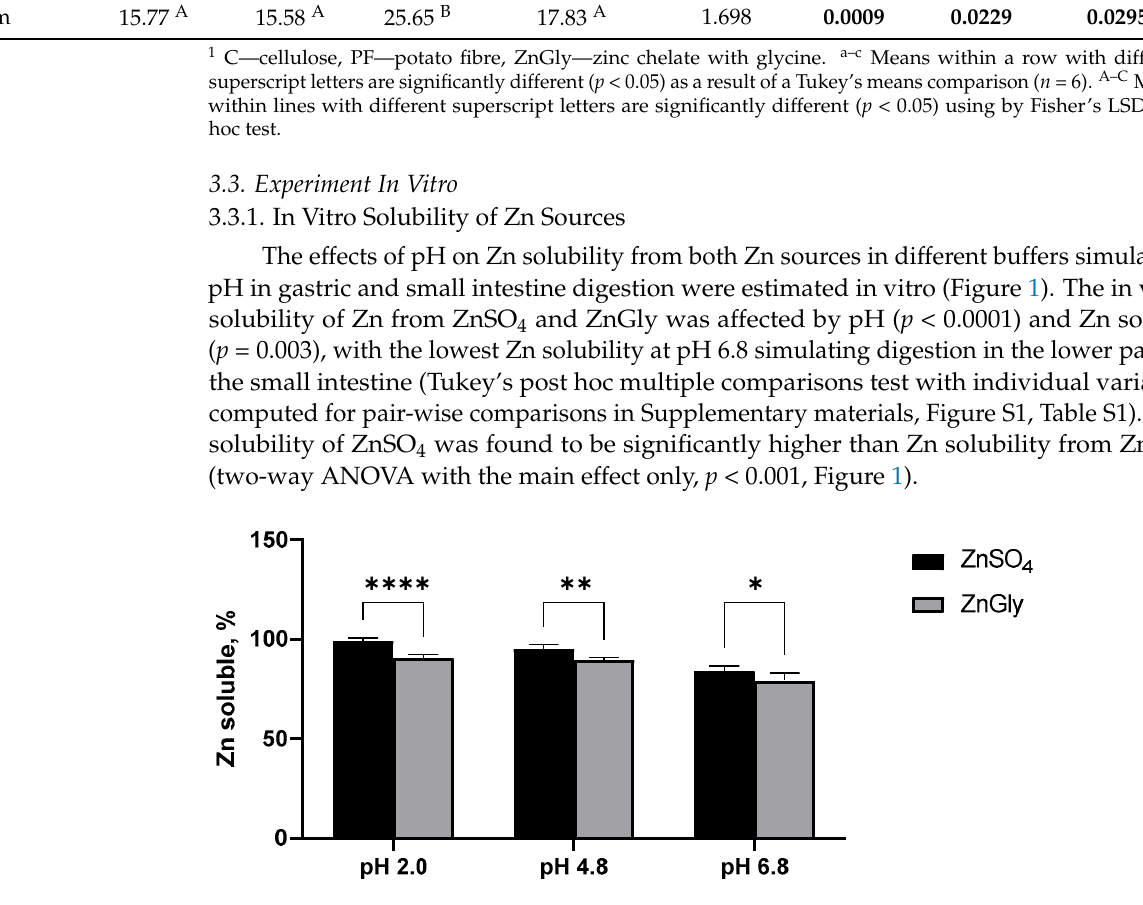
Figure 1. In vitro solubility of Zn from both Zn sources (ZnSO4, ZnGly) subjected to different buffers simulating gastric digestion in 0.2 M Gly-HCl at pH 2.0, or simulating small intestinal digestion in 0.2 M sodium acetate buffer at pH 4.8 and 6.8; Asterisks represent p- value classification (* p < 0.05, ** p < 0.01, **** p < 0.0001).